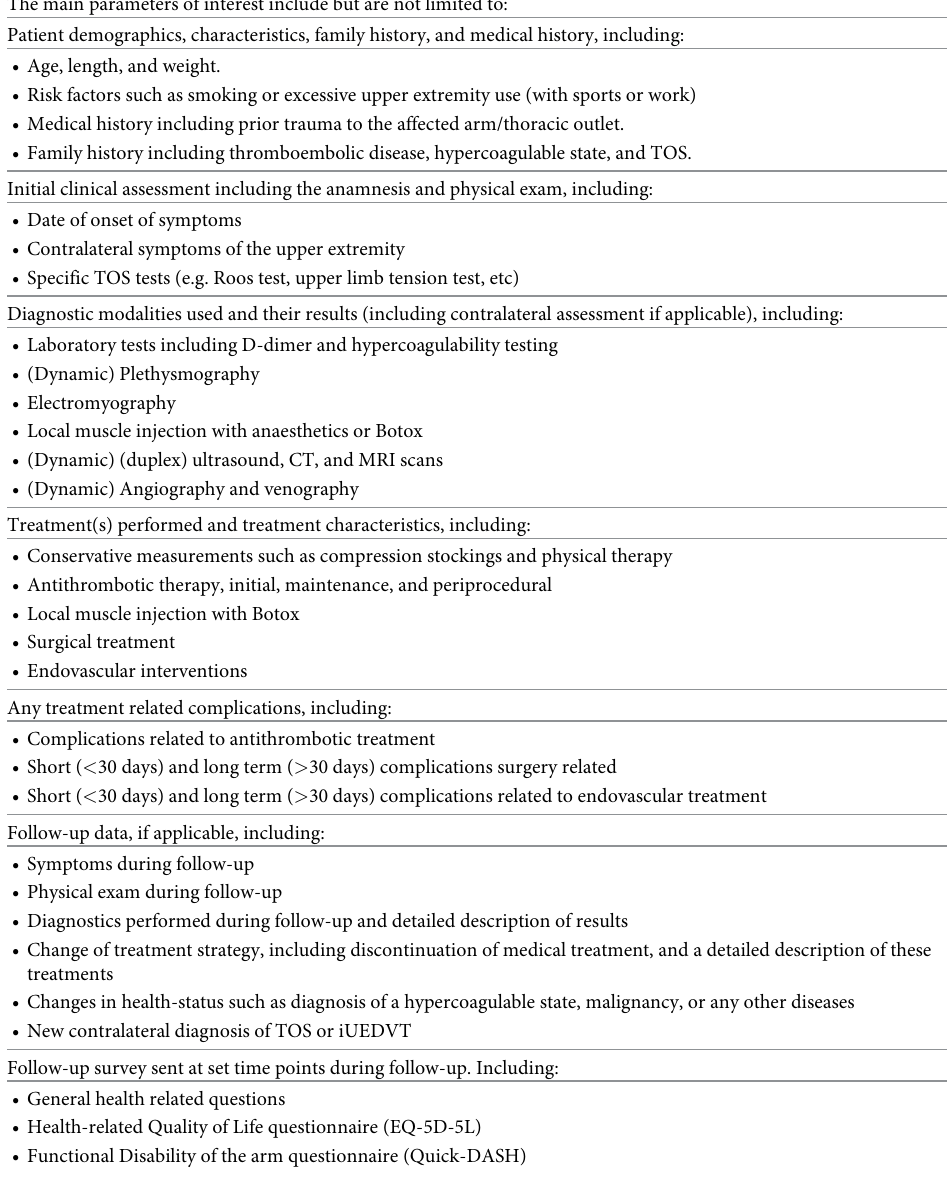
Table 3. Overview of the main collected parameters in the TROTS registry. The main parameters of interest include but are not limited to: Patient demographics, characteristics, family history, and medical history,